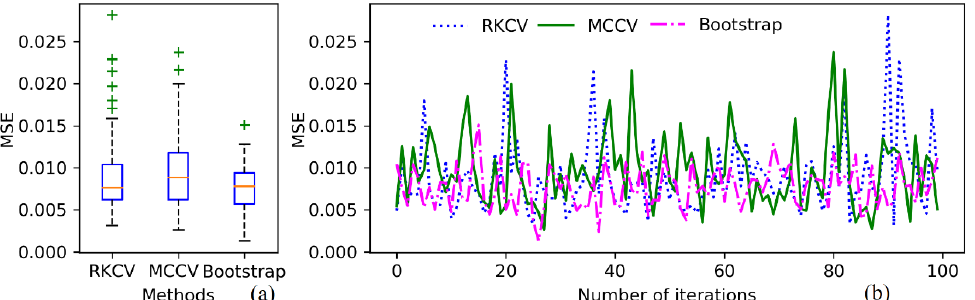
Table 1. Results of different sampling methods based on 100 samples of different sizes; higher performance (i. e., lower m MSE and sd MSE ) gains with increasing sample size.